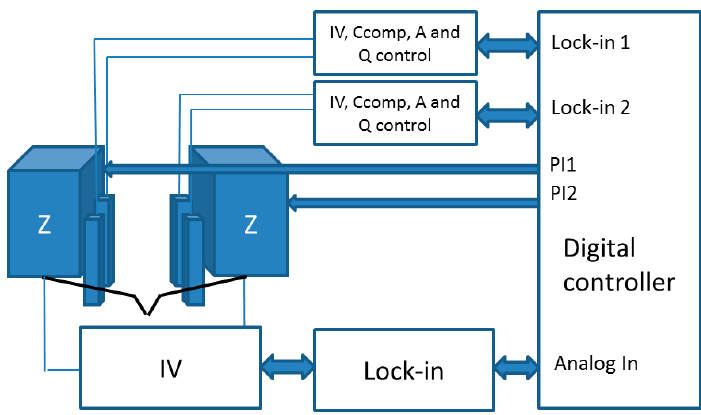
Figure 4. Scheme of the electronics and control system. The shear force between the tips and the surface are measured through custom-designed electronics, and the digital controller uses them to control the tip-sample distance (PI control) by adjusting the Z -axis of the piezoelectric actuators. The impedance between the two tips is measured independently by an I–V and a lock-in amplifier.